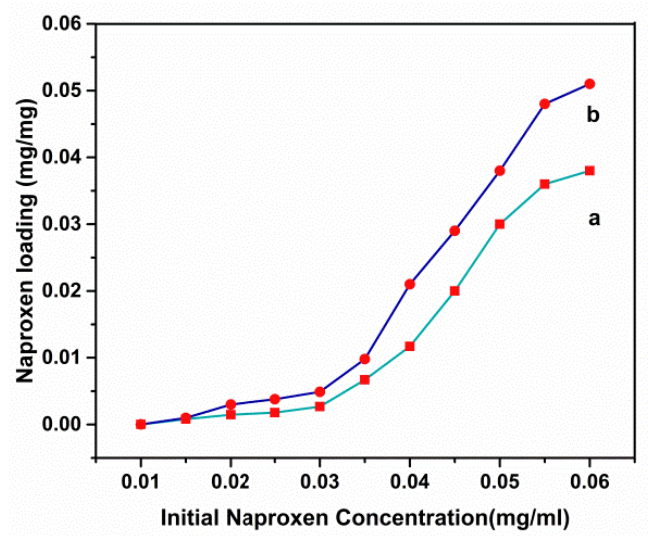
Figure 5. Loading capacity curves of naproxen on the Ni 1−x Co x Fe 2 O 4 @Methionine NPs ( a ) and Ni 1−x Co x Fe 2 O 4 @Methionine@PEG NPs ( b ) at different initial concentrations of the drug. Figure 6 represents the percentage of naproxen released from the Ni 1−x Co x Fe 2 O 4 @Me- thionine and Ni 1−x Co x Fe 2 O 4 @Methionine@PEG NPs synthesized as described above (37 °C). For the simulated tumor environment, pH values of −5 and −7 .4 were specified. In 120 h, the release rates of both carriers were lower in neutral solution settings (pH 7.4) than in